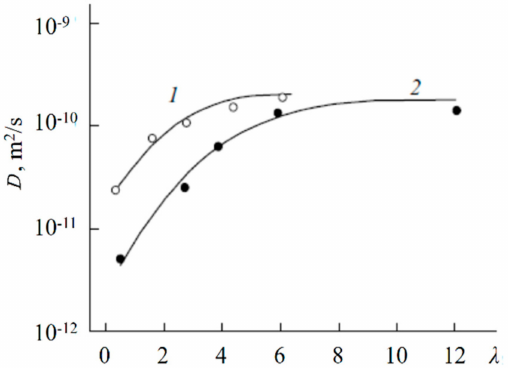
Figure 47. Diffusion coefficients of water on the moisture content in the acidic form of membranes MF-4SC with the exchange capacity of 0.86 (1) and 0.34 mg-equiv. · g − 1 (2) [39,105]. Reprinted with permission from [105]. Copyright 2013 Turpion Limited.